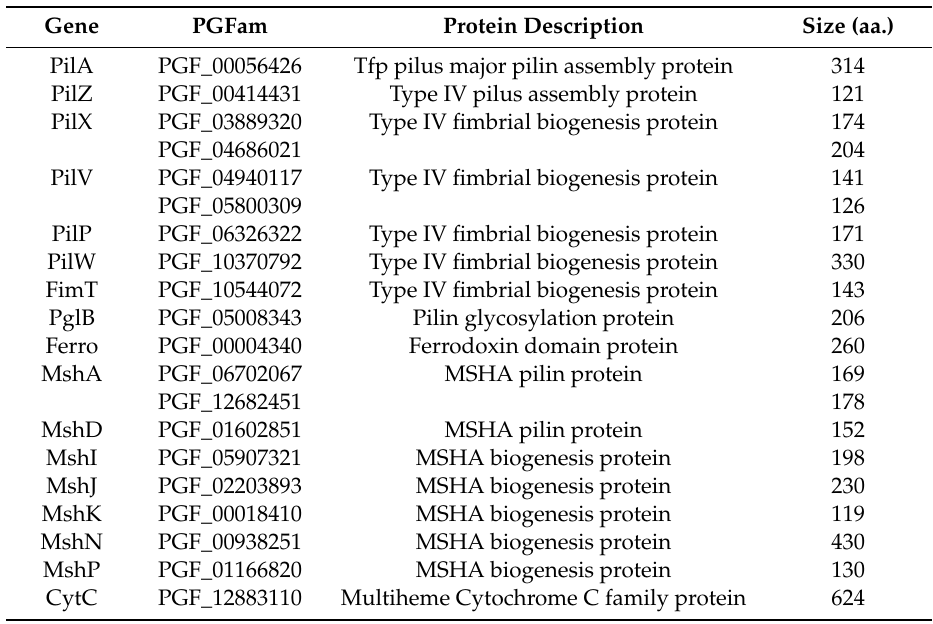
Table 4. Overview of some of the PGFams uniquely identified in Ds . strains DSM 1675 (2-K), DSM 1676 (N2), N3, and DSM 684 (red clade in Figure